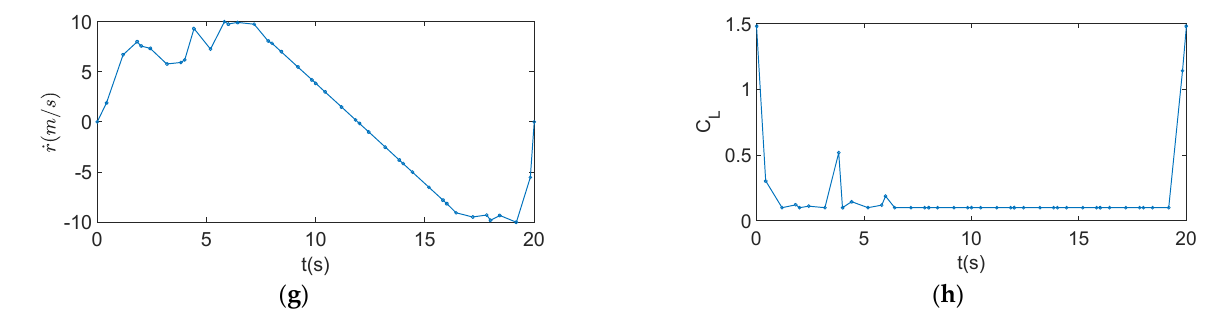
Figure 9. State variables’ optimization results by PSM. ( a ) Pitch angle. ( b ) Yaw angle. ( c ) Cable length. ( d ) Roll angle. ( e ) Pitch angular rate. ( f ) Yaw angular rate. ( g ) Cable velocity. ( h ) Lift coefficient.